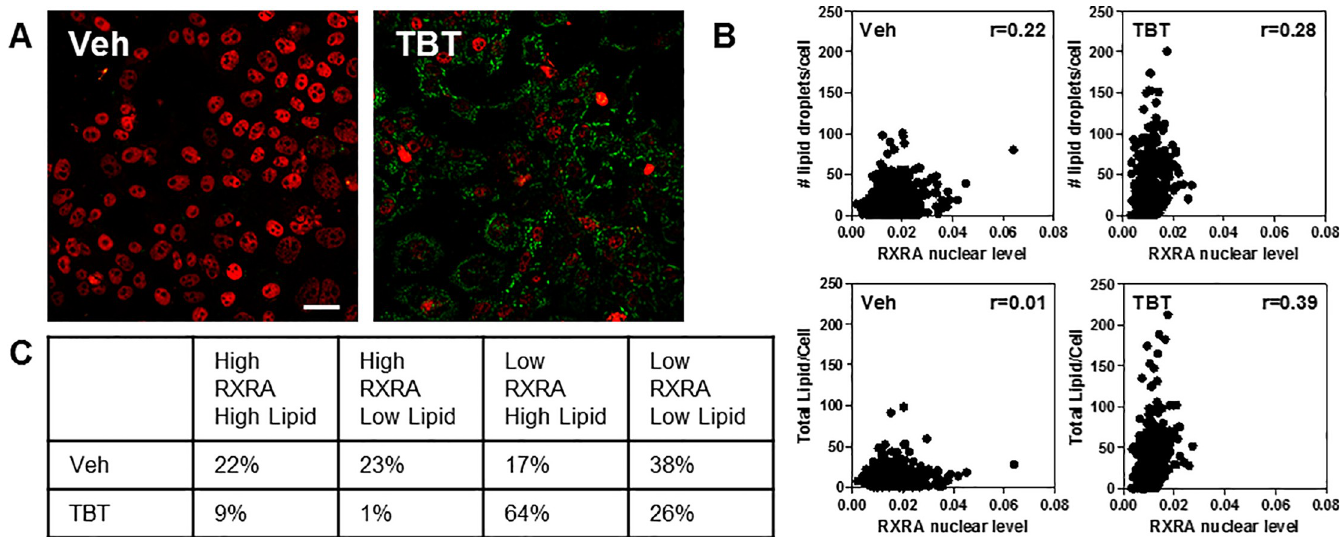
Fig 6. RXRA levels do not correlate with lipid content before or after TBT treatment. A) HepaRG cells were treated TBT (50 nM) or vehicle for 72 h hours, then immunofluorescence using specific RXRA antibody (red), together with LipidTox staining (green), was performed and single cell nuclear levels of RXRA, lipid droplet counts and total lipid content were measured. Scale bar: 25 μ m. B) Scatter plots showing no significant Spearman r correlation coefficients under both measurement and treatments. C) Table showing the % of cells having either high or low RXRA nuclear level and number of lipid droplets as measured considering the mean values in the vehicle control